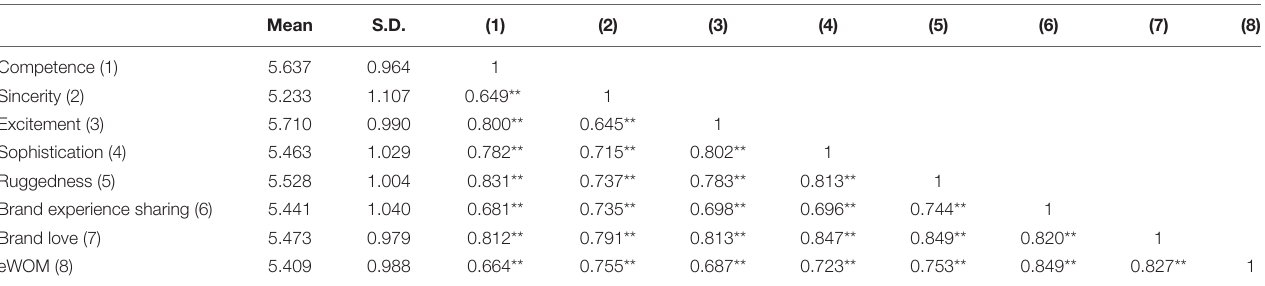
TABLE 4 | Descriptive